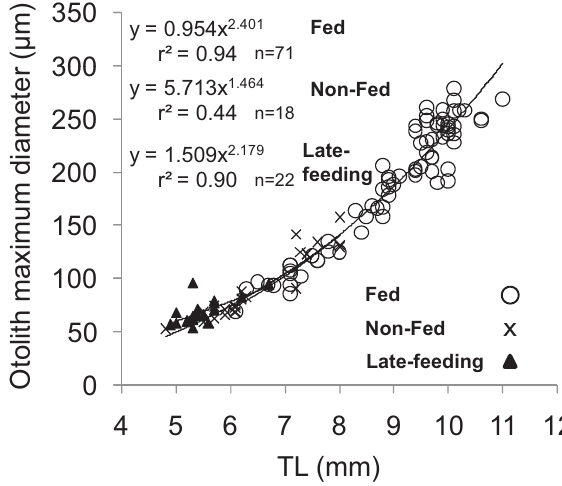
Fig . 3. – relationships between otolith size of the condition experi- ment (maximum diameter) and larval body size (total length, tl) for the three main feeding treatments (the length range was too small in the fourth treatment for regression analysis). the sample size is indicated by n.